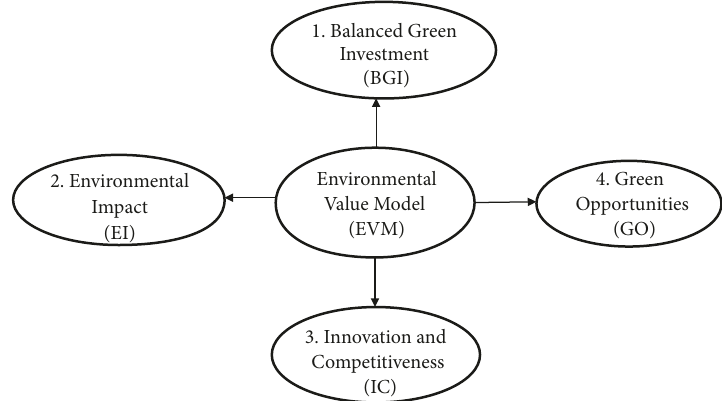
Figure 1: Environmental Value Model